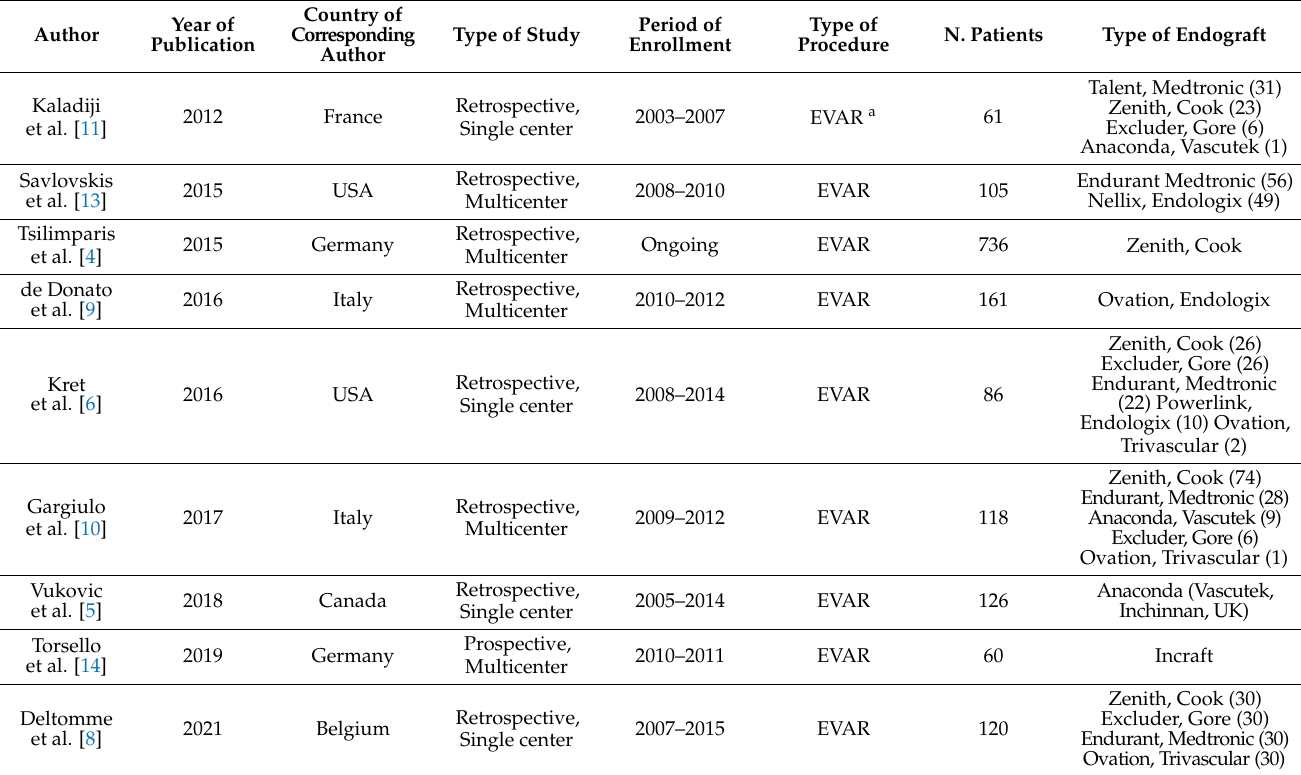
Table 1. Characteristics of included